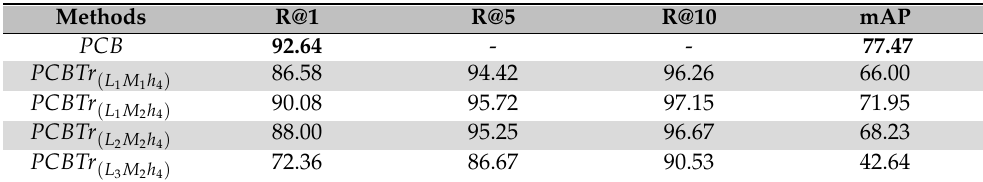
Table 3. The performance of the PCB Transformers (PCBTr) and baseline (PCB) for Market-1501 [39] datasets. The best results are in bold. The subscripts of “L”, “M” and “h” represent the presence of transformers after that block, the number of transformers after each block, and the number of heads in the model, respectively.